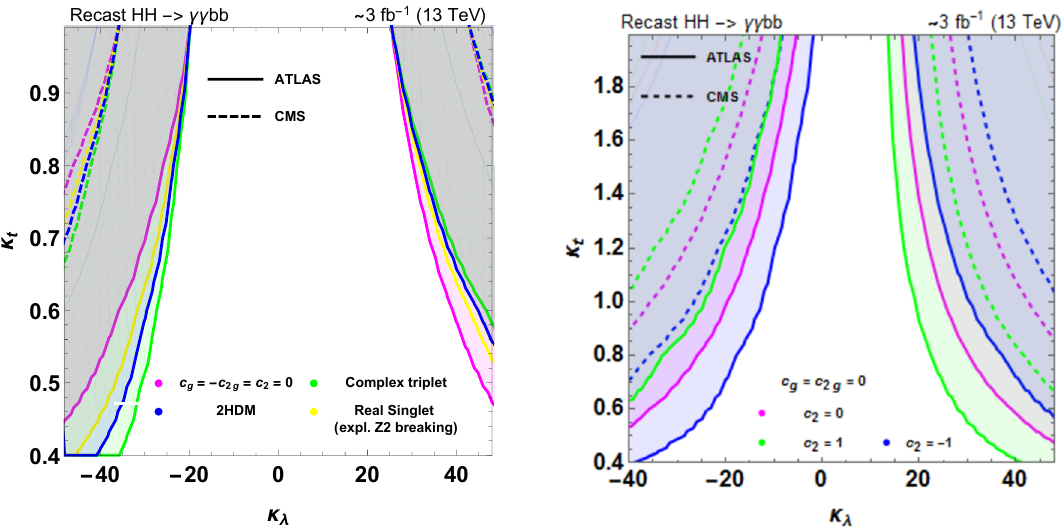
Figure 4 . ATLAS (continuous lines) and CMS (dashed lines) 95% exclusion bounds in the κ λ − κ t plane, reinterpreted in terms of different models (left) and in the pure EFT framework for different values of c 2 (right). See text for